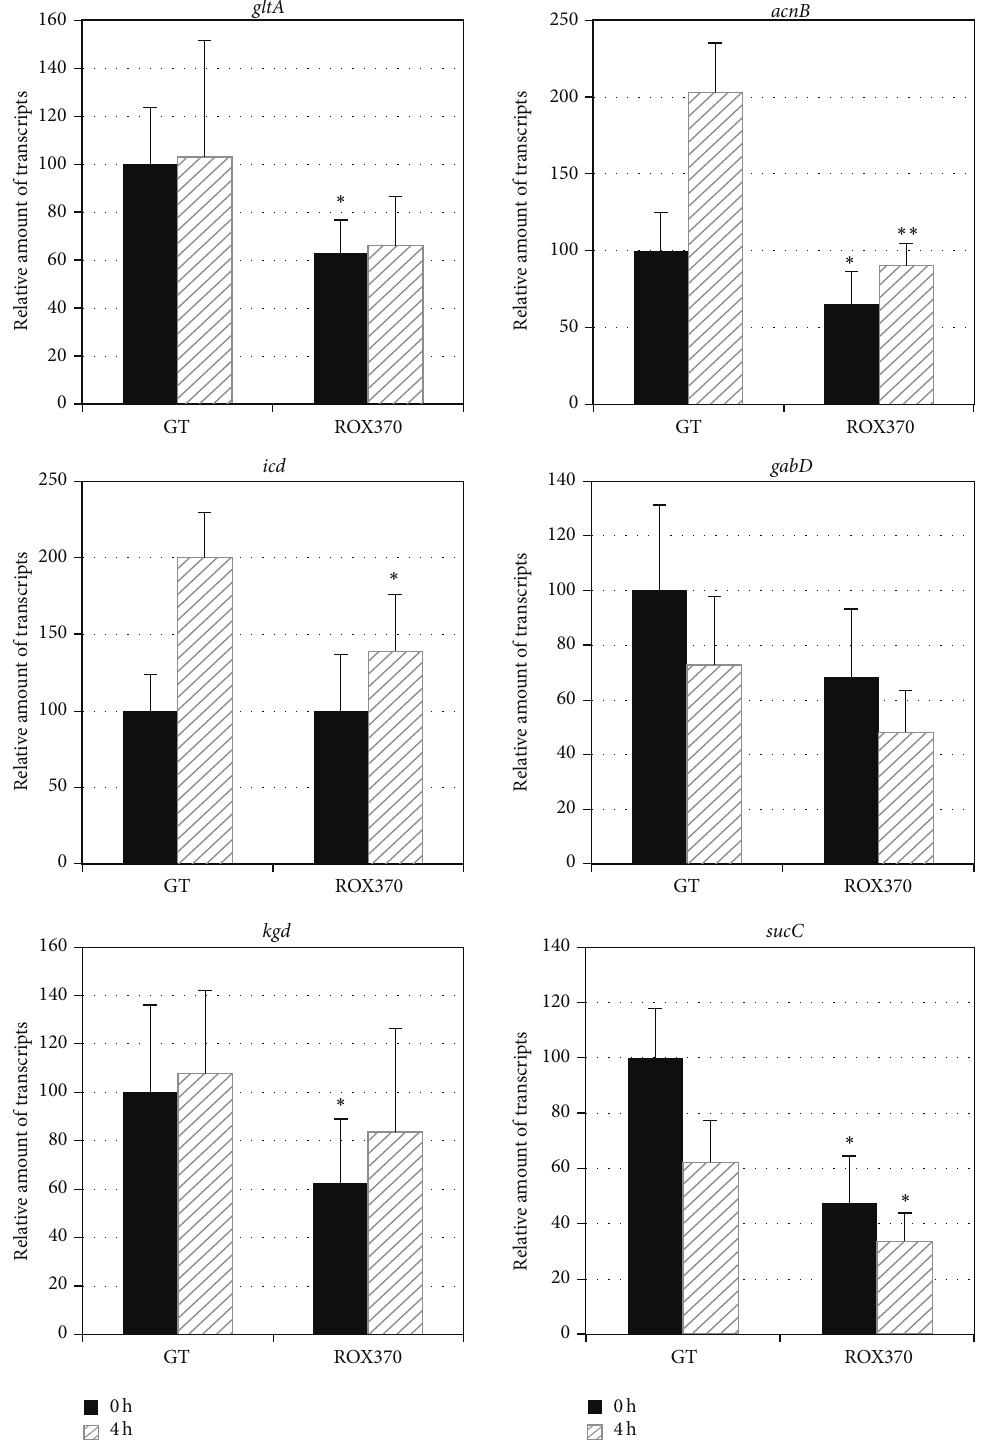
Figure 1: Quantitative real-time PCR analysis of transcription in GT and ROX370. Relative transcript levels of 6 genes involved in the TCA cycle pathway ( gltA , acnB , icd , gabD , kdg , and sucC ) are described. Data represent the mean ± SD from four independent experiments. Transcript levels were calibrated relative to that of corresponding levels in GT under nitrogen-replete conditions (set at 100%). Asterisks indicate statistically significant differences between GT and ROX370 (Student’s 𝑡 -test; ∗ 𝑃 < 0.05 , ∗∗ 𝑃 < 0.005